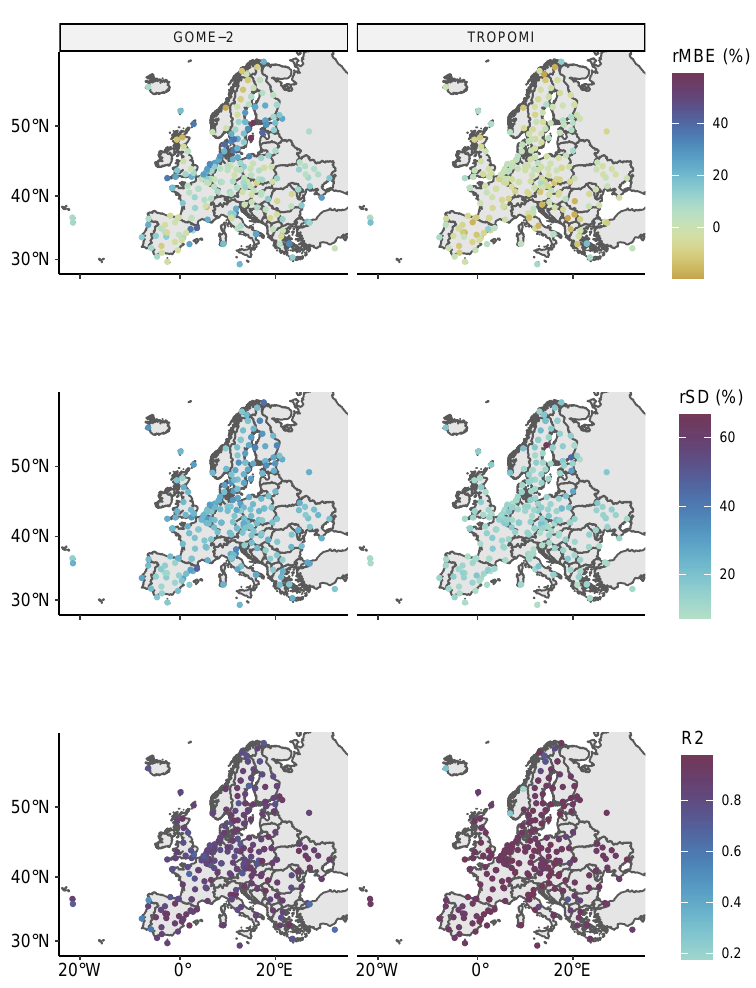
Figure 3. Maps of rMBE ( top ), rSD ( middle ) and R2 ( bottom ) of TROPOMI ( left ) and GOME-2 ( right ) IWV with respect to GNSS